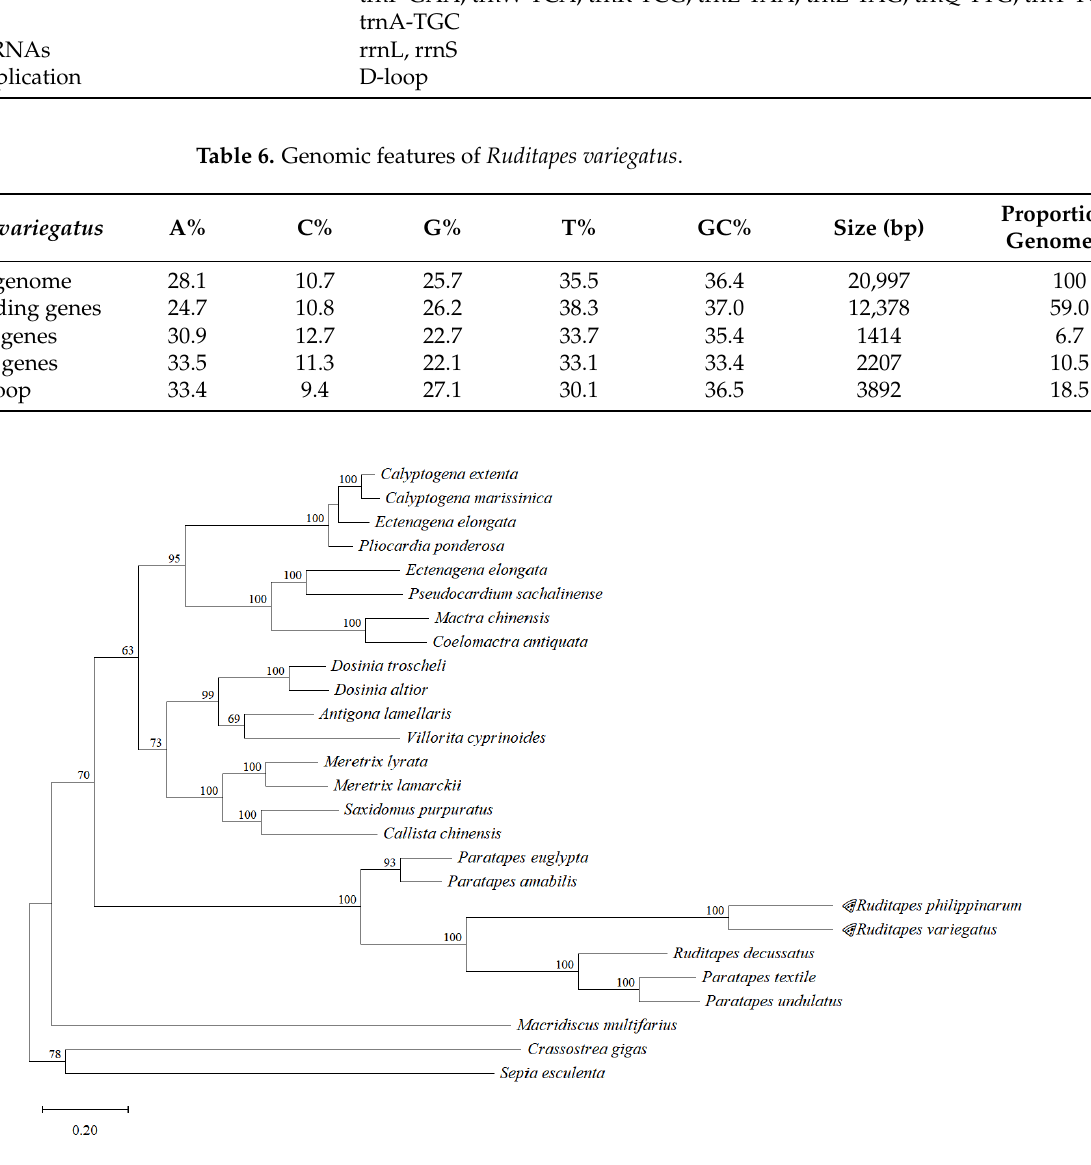
(Figure 5: only the evolutionary trees constructed using the whole genome were shown).